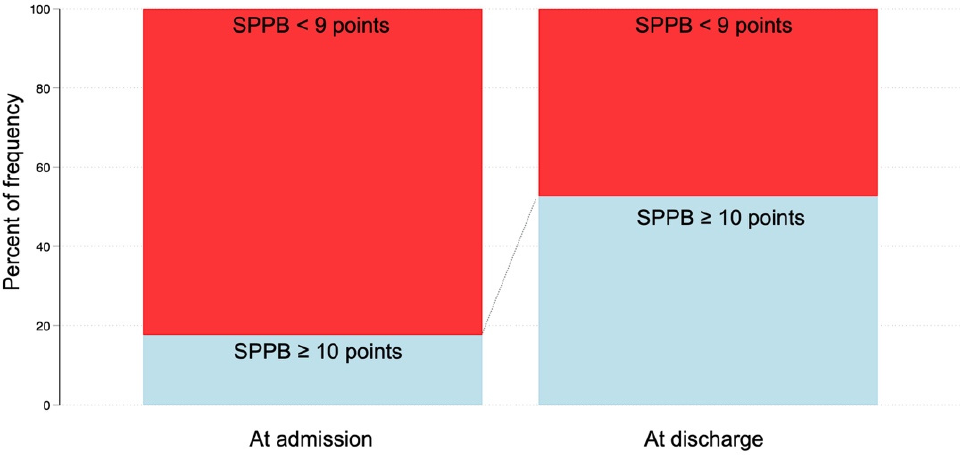
Figure 3. Prevalence of sarcopenia defined as SPPB < 9 points.